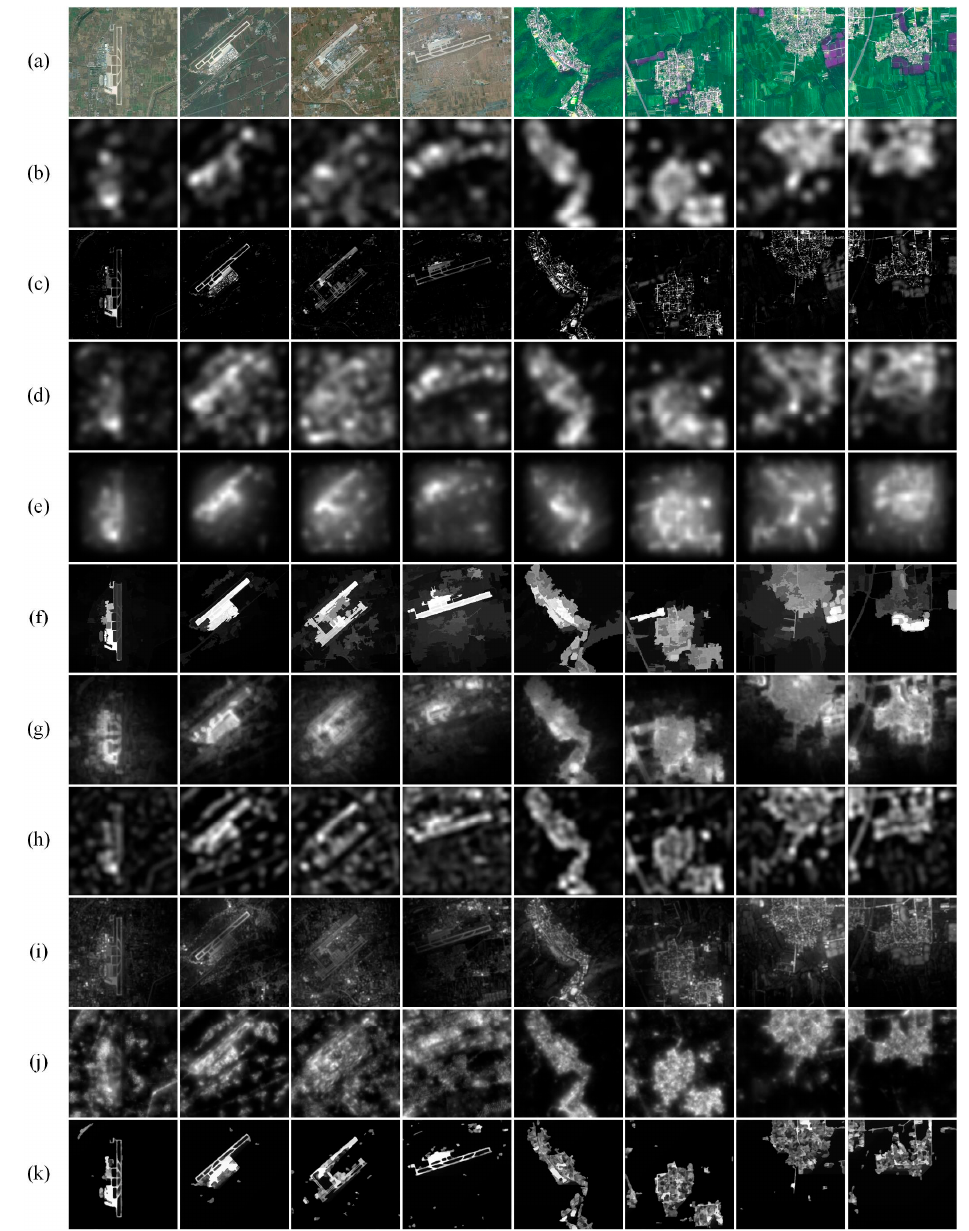
Figure 7. Comparison of saliency maps for noise-free images (first four images are from the SPOT5 satellite and last four are from Google Earth): ( a ) remote sensing image; ( b ) SR; ( c ) FT; ( d ) ITTI; ( e ) GBVS; ( f ) H; ( g ) CA; ( h ) FDA; ( i ) WT; ( j ) MFF; and ( k )